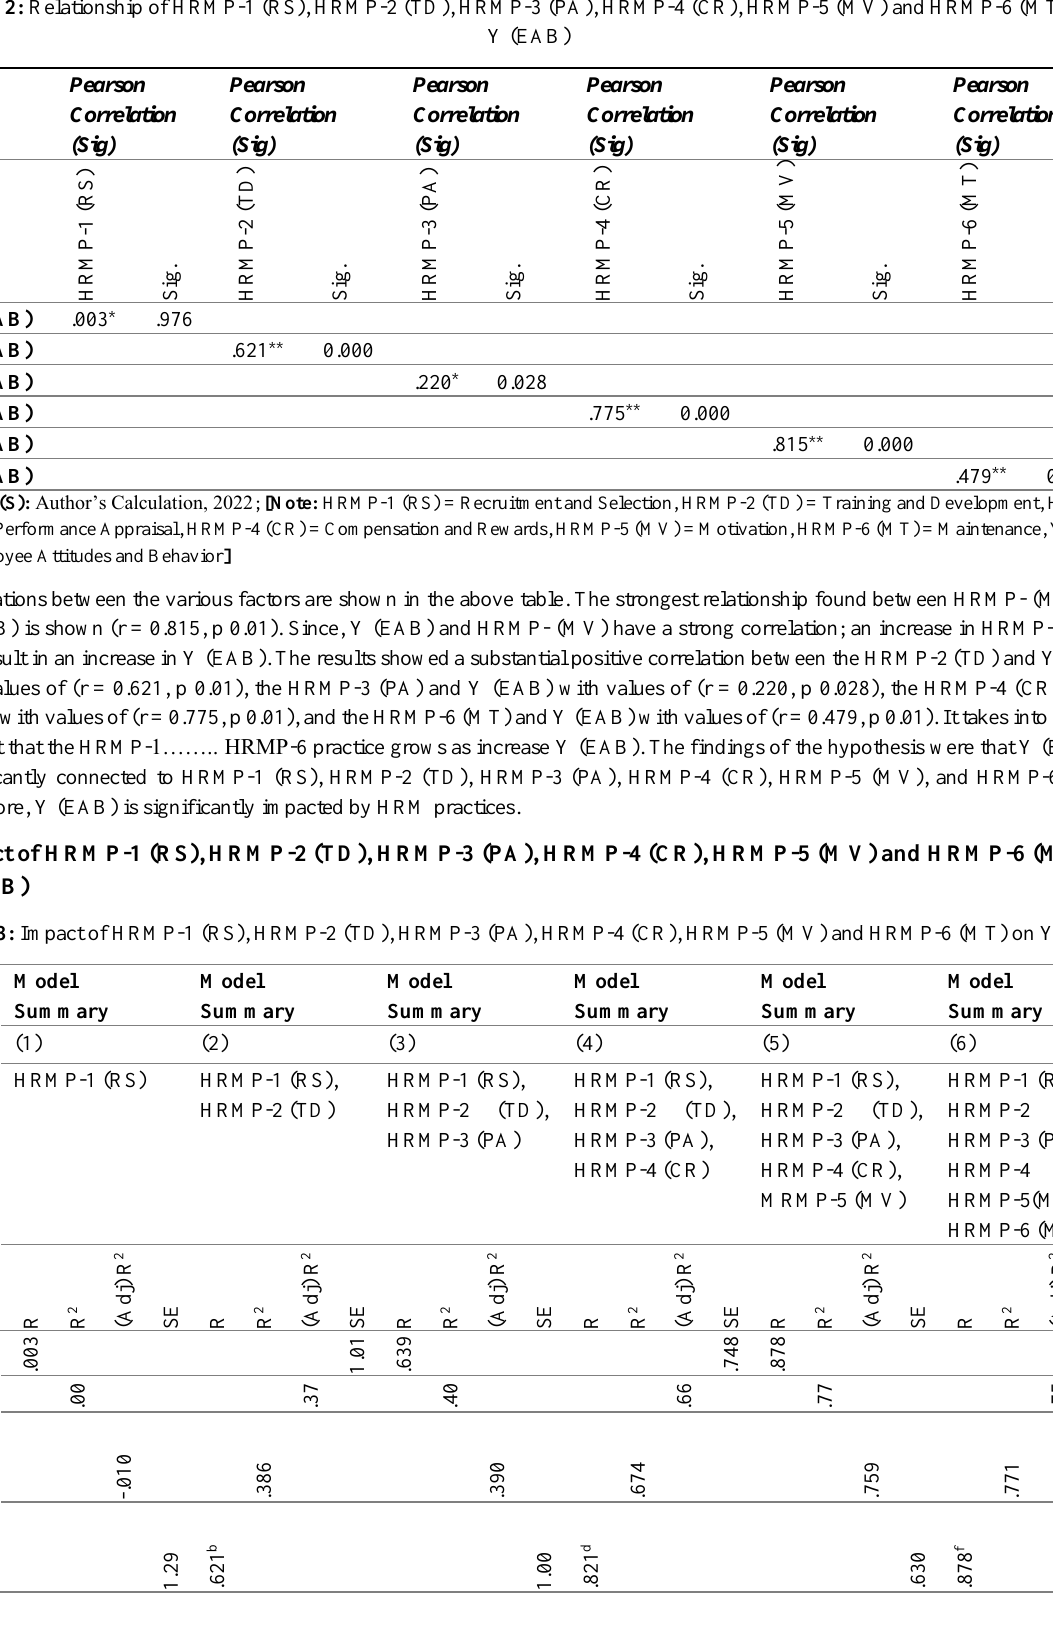
Pearson Correlation